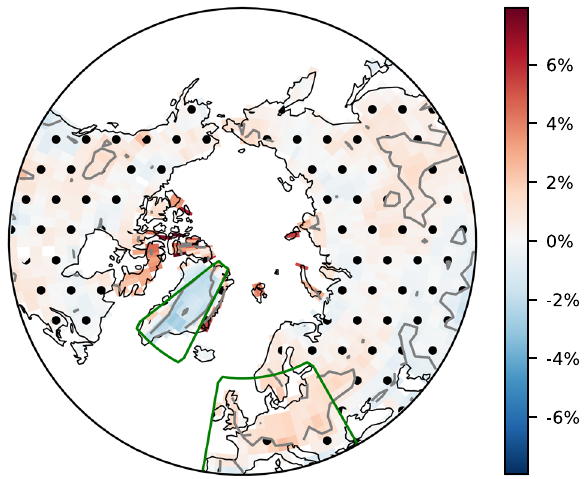
Fig. 4 Few regions show signi fi cant heatwave change on top of the mean temperature increase. Shadings show the multi-model- mean change in heatwave frequency when mean temperature increase is removed, in SSP585 (2060 – 2099) minus historical (1966 – 2005). Dots enclosed in grey contours denote regions where the changes are NOT statistically signi fi cant. Europe and Greenland (land points in green boxes) are studied in more